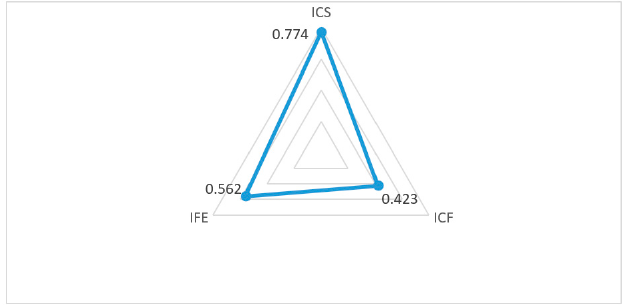
Figure 2. Three-level model of financial support for the development of the studied textile enterprises on the optimal value basis. Source: author’s own calculation.